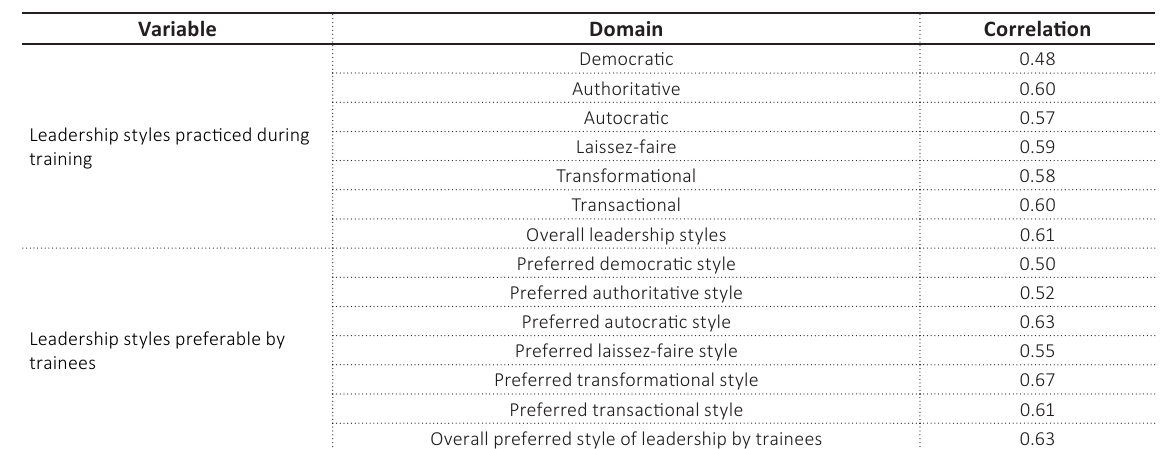
Table 2. Pearson correlation